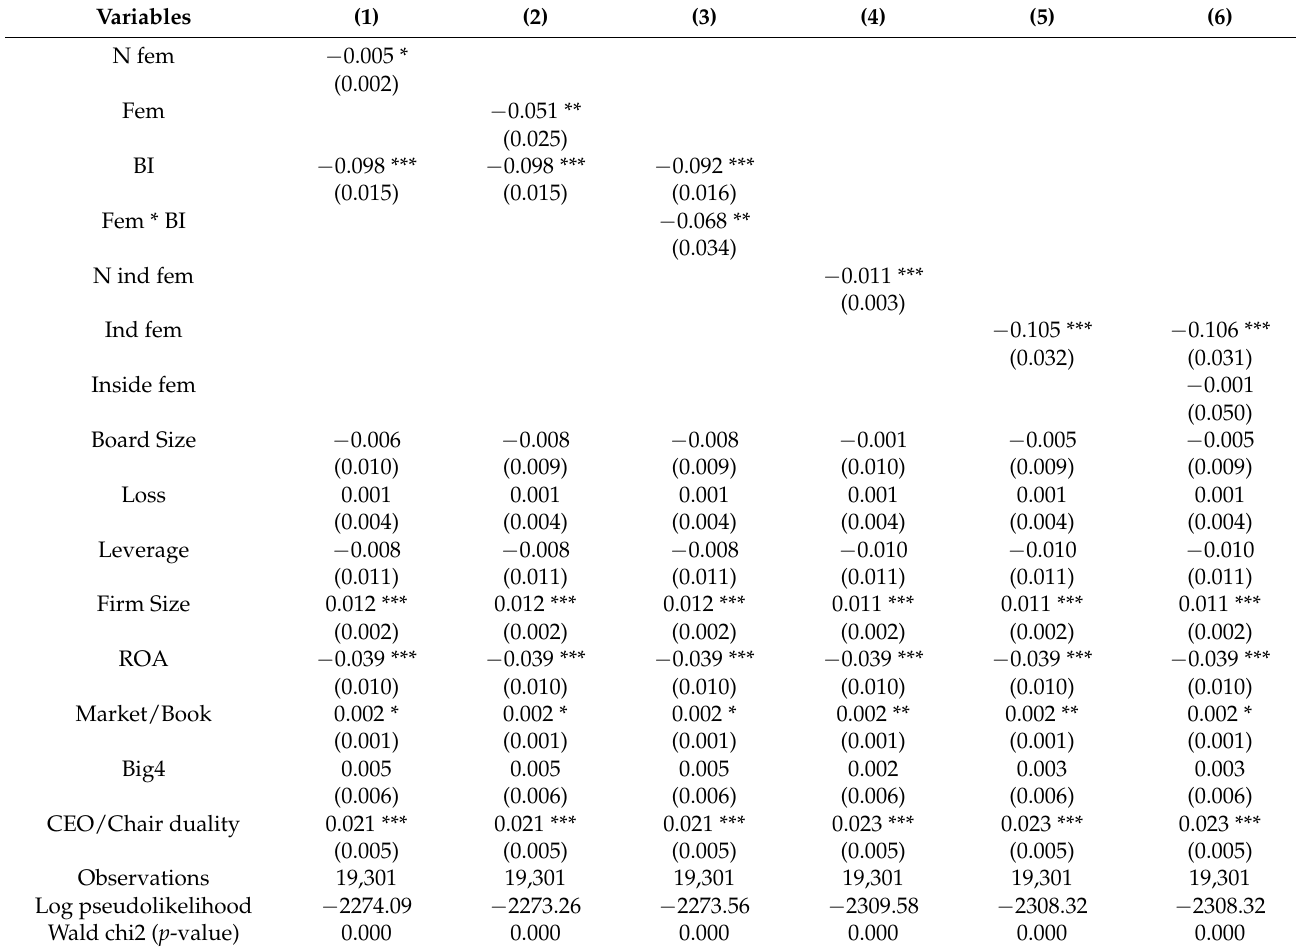
Table 5. Financial fraud and female directors (marginal